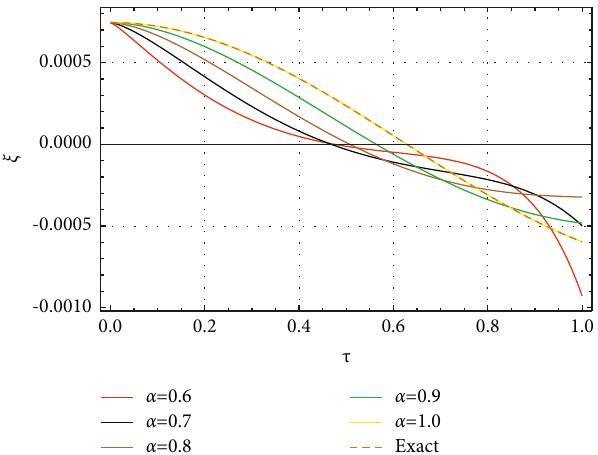
Figure 7: The approximate and exact solutions to the real part of Example 4.